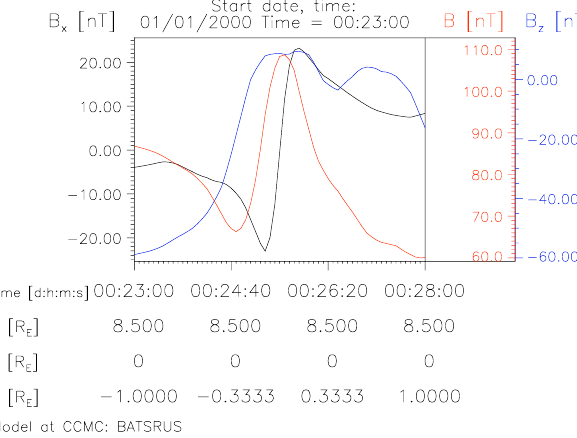
Fig. 7. Magnetic field data ( B x , B z , B ) from a virtual satellite cross- ing the interlinked flux tubes in the z direction. The satellite trajec- tory goes from z = − 1 to 1 R E at x = 8 . 5 R E and y = 0.